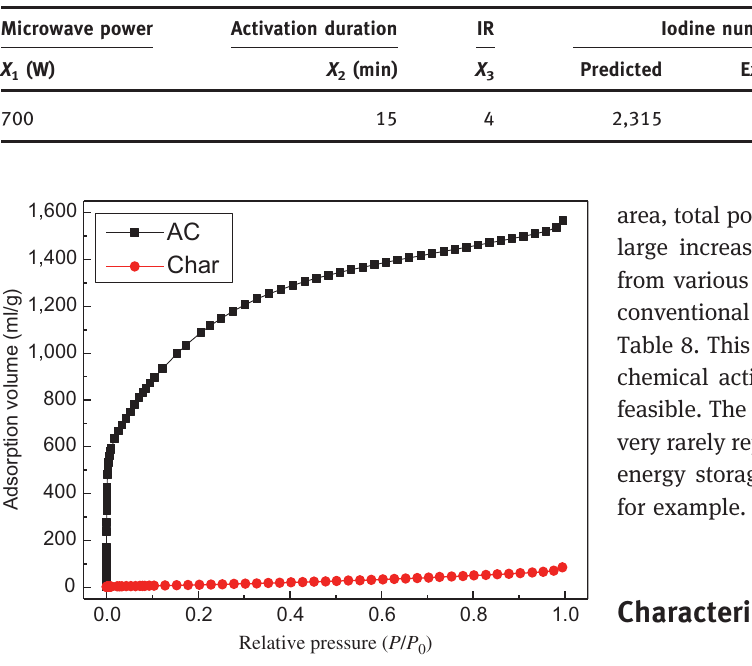
Table 7: Pore structure of Char and AC.